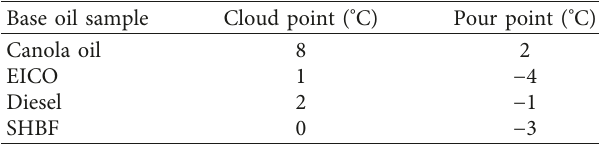
Table 7: Cloud and pour points of base fluid samples.